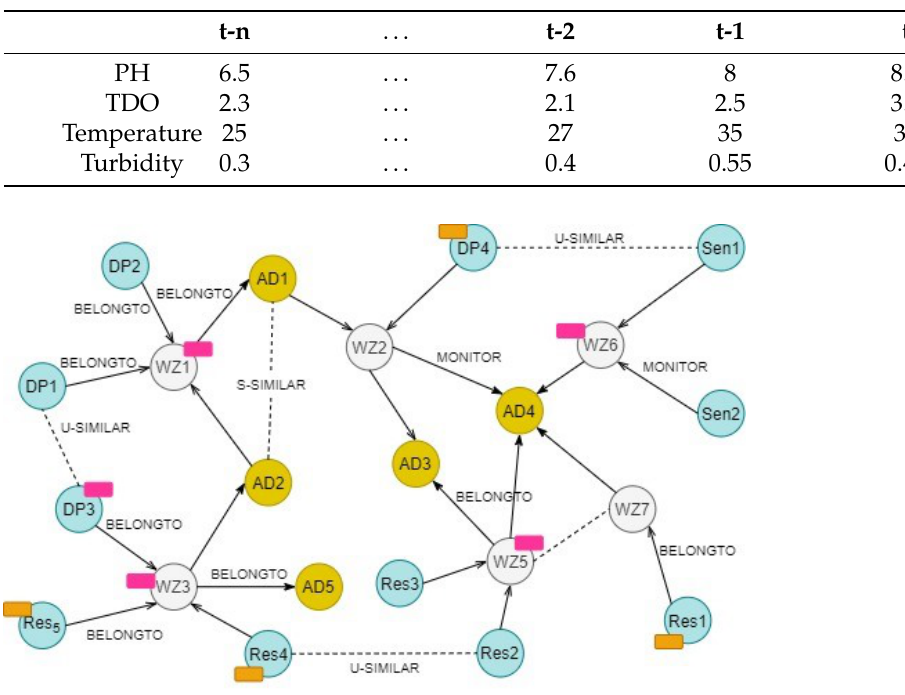
Figure 4. Updated WIN after the monitoring